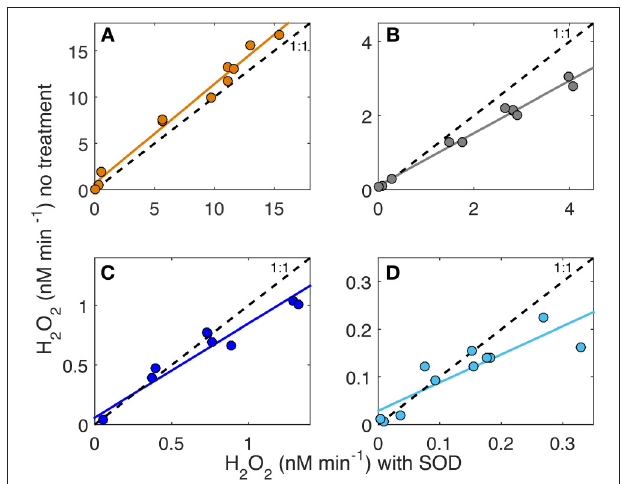
FIGURE 4 | H 2 O 2 (nM) generated in untreated samples vs. samples treated with added superoxide dismutase (SOD) in each AQY experiment under various light fields (cutoff filters) for the Altamaha River (A) , Skidaway River Estuary (B) , Midshelf (C) , and the Gulf Stream (D)